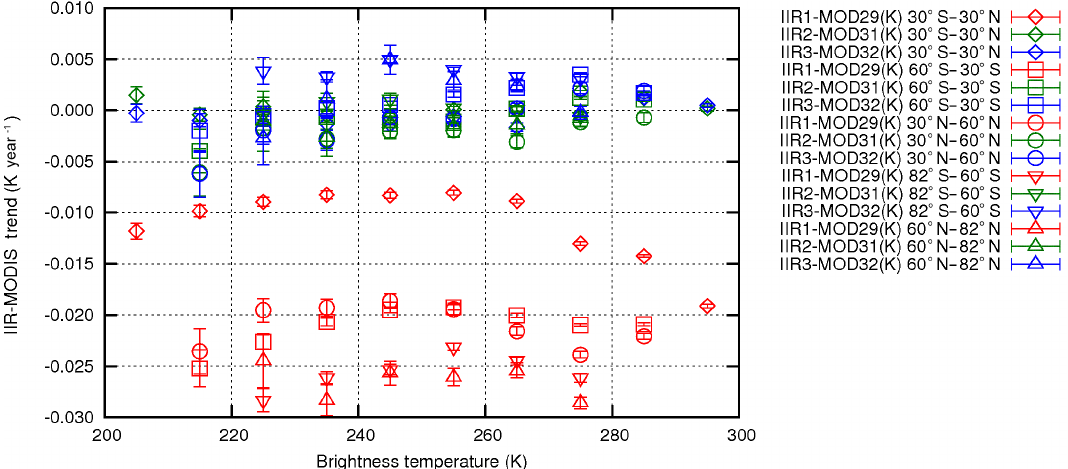
Figure 10. Trends of IIR–MODIS brightness temperature differences and associated uncertainties against temperature for the three pairs of companion channels (red: IIR1–MODIS29, green: IIR2–MODIS31, blue: IIR3–MODIS32) as derived from Figs. 3 to 7. Latitude bands: diamond, 30 ◦ S–30 ◦ N; square, 60–30 ◦ S; circle, 30–60 ◦ N; inverse triangle, 82–60 ◦ S; triangle, 60–82 ◦